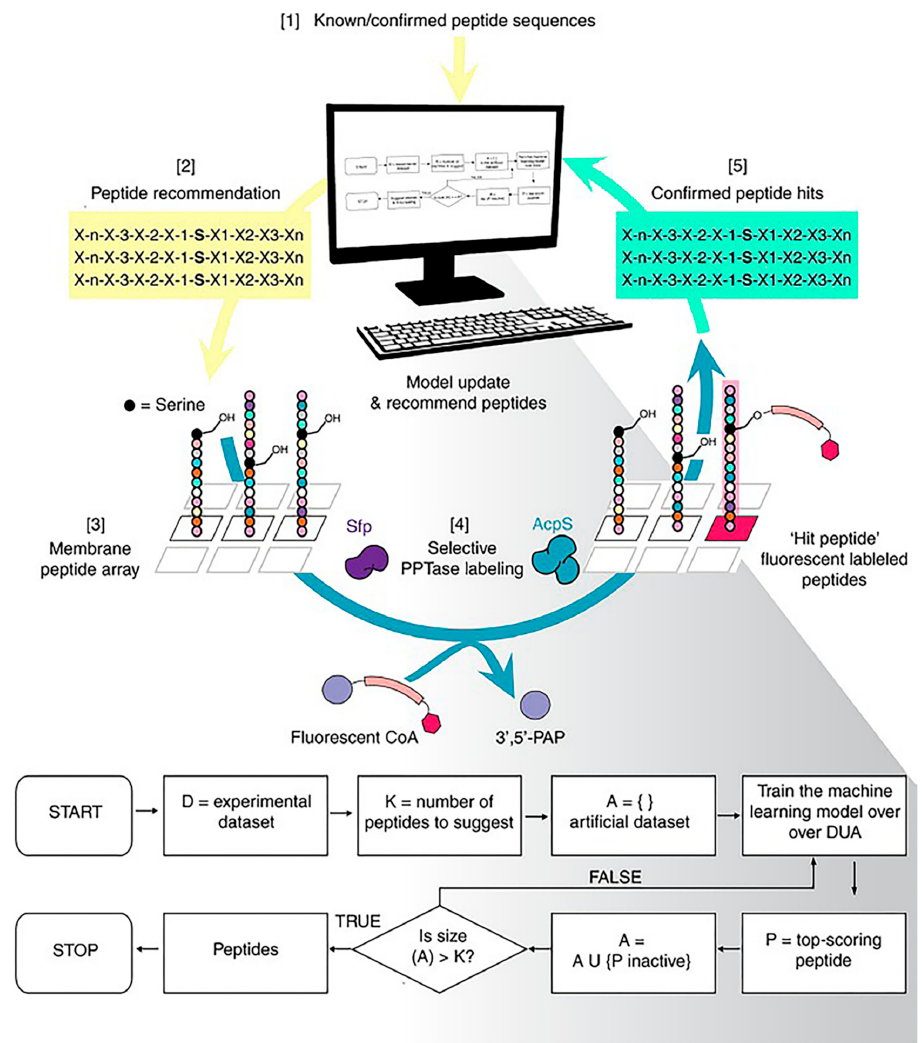
Figure 8. Machine-learning-based strategies for peptide screening. Using the peptide optimization with optimal learning (POOL) method to discover orthogonal peptide substrates for 4 ′ -phosphopantetheinyl transferase. Reproduced from Reference [50] with permission. Copyright: 2017 Springer Nature.